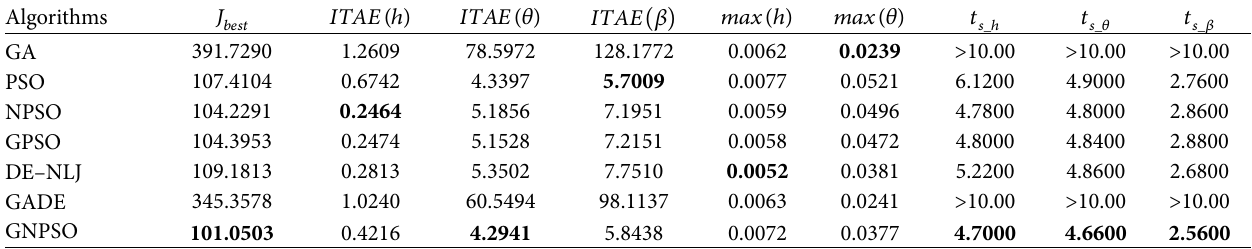
Table 11: Comparison of the control performance obtained by GA, PSO, NPSO, GPSO, DE–NLJ, GADE and GNPSO for nonlinear wing vibration system.